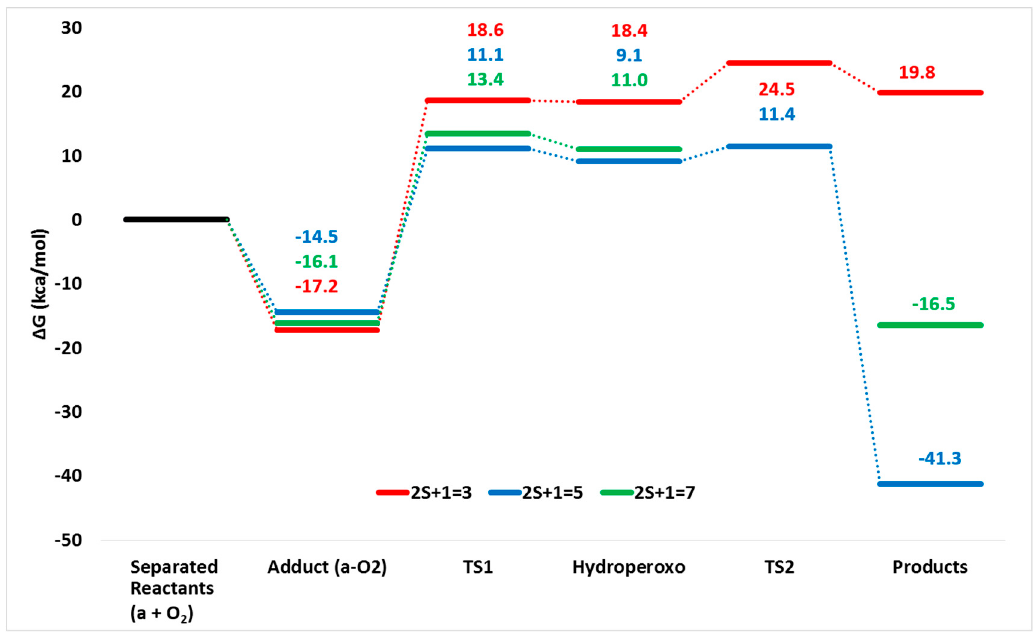
Figure 4. M06L potential energy surfaces (PESs) for oxidative decarboxylation operated by non ‐ heme biomimetic model ( a ) at different spin states (triplet, quintet and septet).